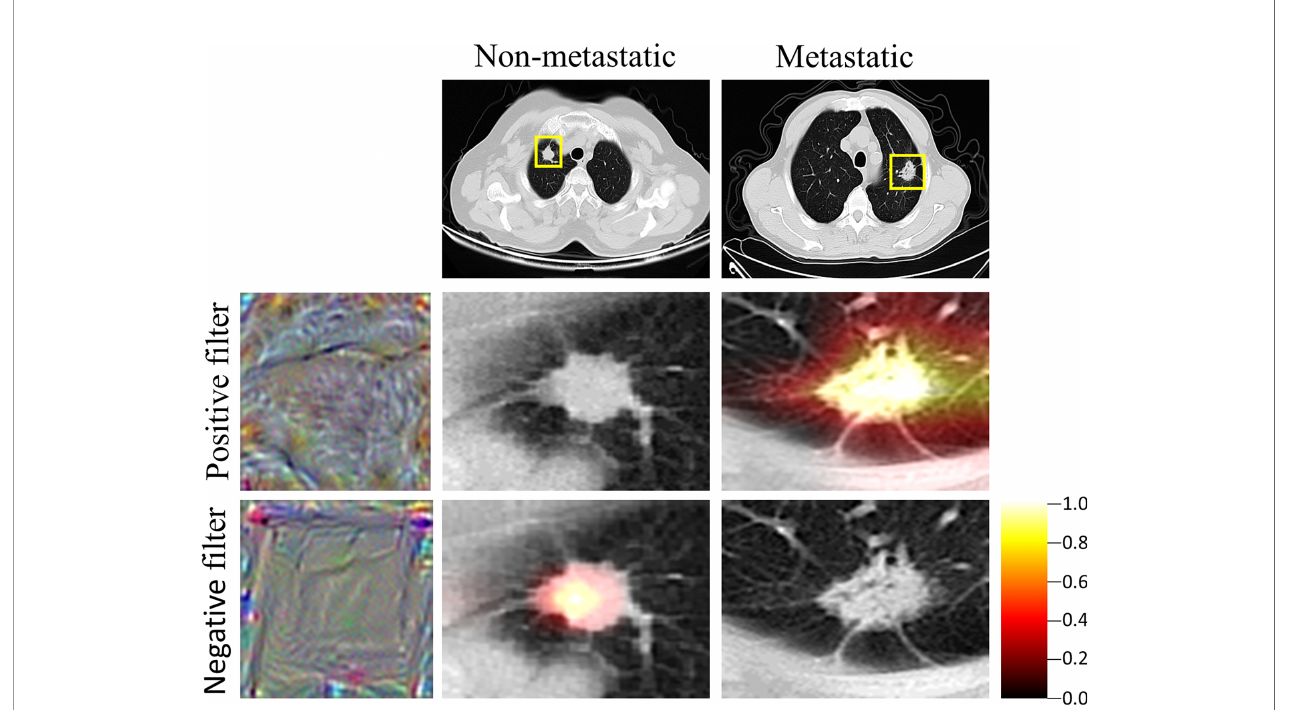
FIGURE 3 | Heat map of VGG. Grad-cam showed the region of interest of the VGG, which was also the region where the features were extracted by the VGG. The closer the color is to yellow, the more important is the region.